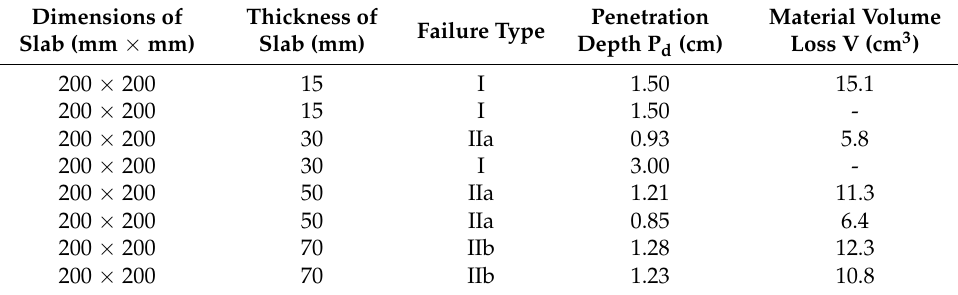
Table 6. Projectile impact results for mixture 6(5-1)/16/6-R.